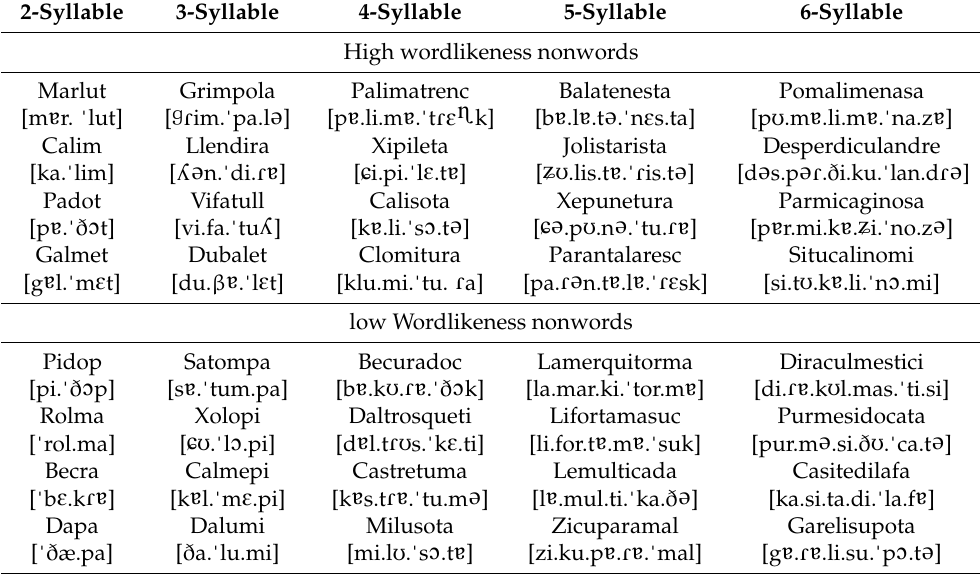
Table A1. The phonetic transcriptions in International Phonetic Transcription (IPA) of the nonwords for the Catalan version of the Nonword Repetition task (NRT-Cat) by syllable length and wordlikeness.